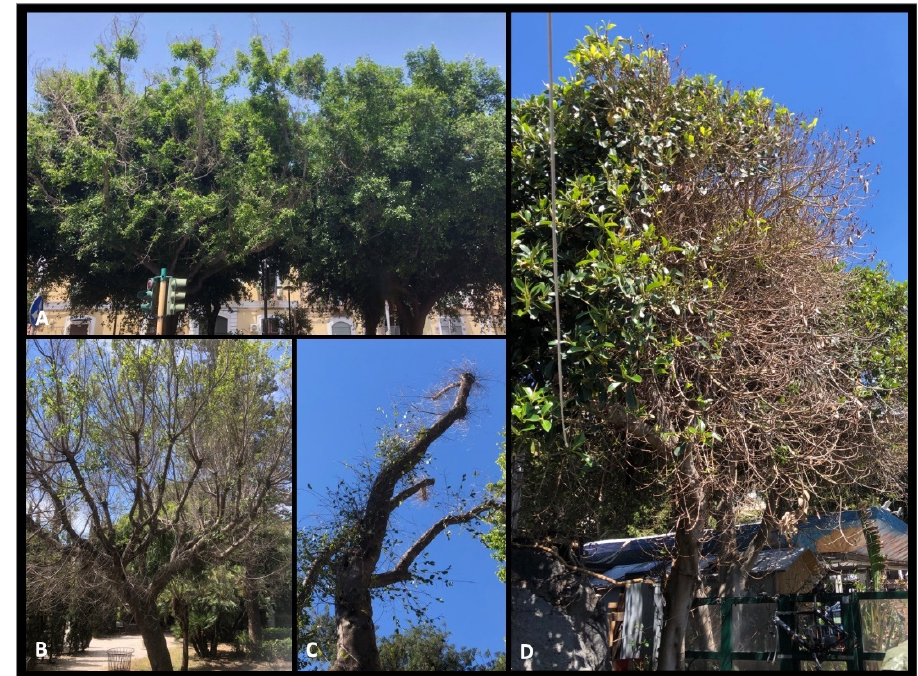
Figure 1. Symptoms of Botryosphaeriaceae disease observed in urban areas on F. microcarpa . ( A ) Diseased (left) and healthy (right) plants. ( B – D ) Defoliation and shoot dieback all over the canopy. ( C ) New twigs growing below the dead shoots.